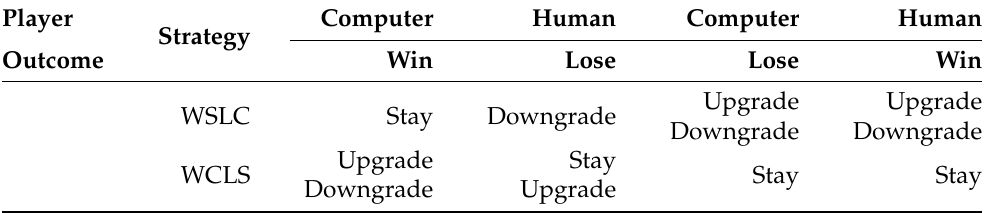
Table 2. Best actions of human players to beat computer opponents that play stay/change